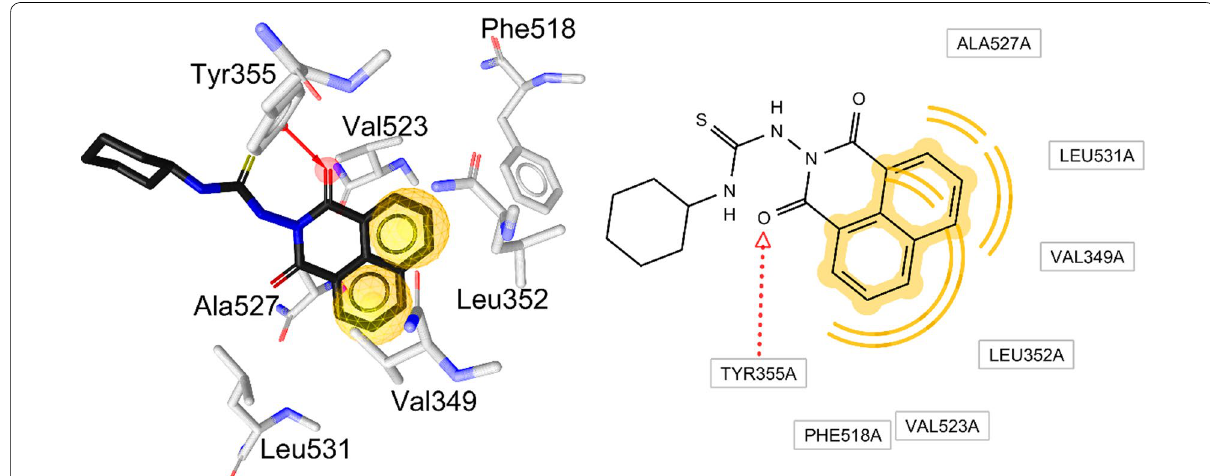
Fig. 6 The predicted binding mode of 15 in the COX‑2 pocket (PDB: 4COX). Above: 3D (left) and 2D (right). Yellow spheres denote hydrophobic contacts. Red arrow represents hydrogen bond